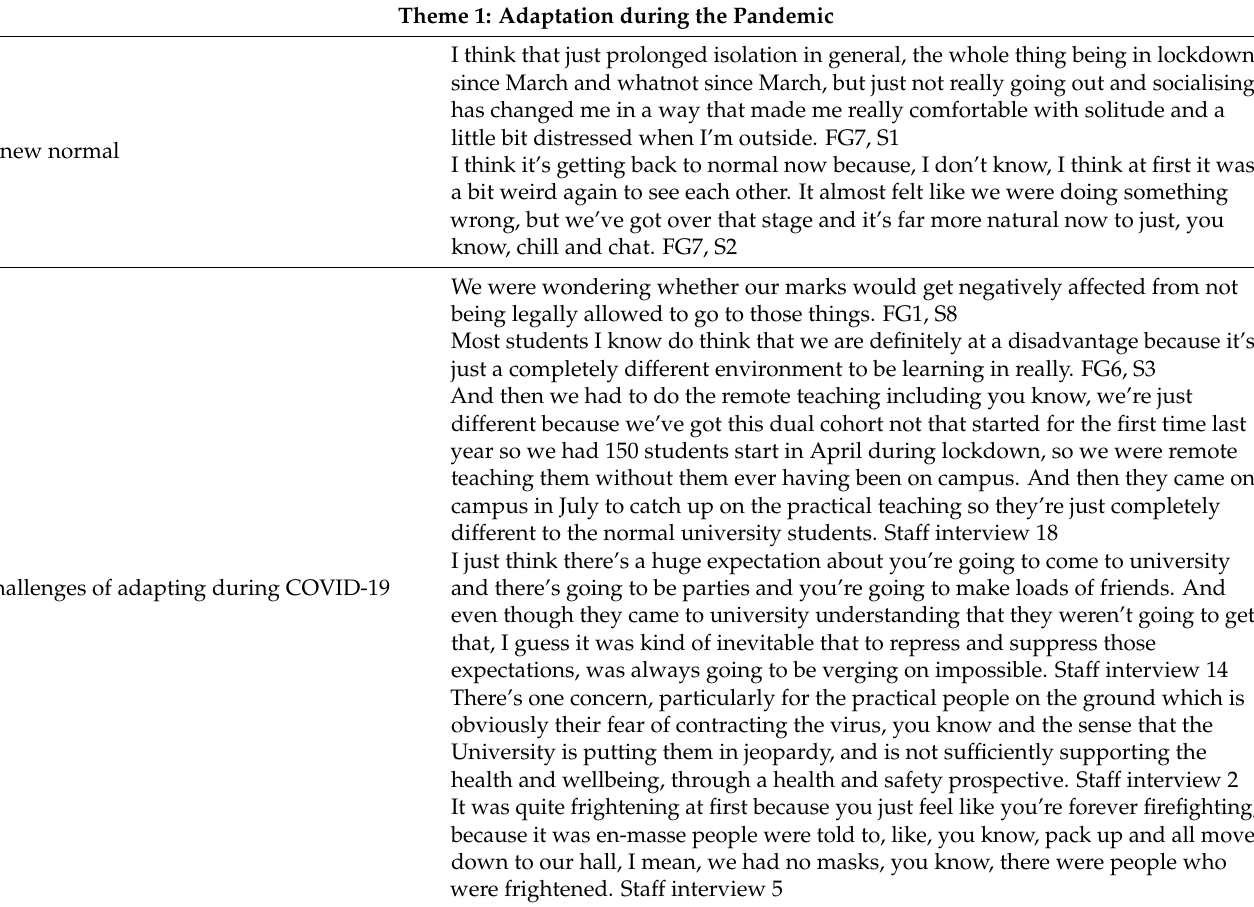
Table 3. Examples of key themes, subthemes, frequency, and their representative